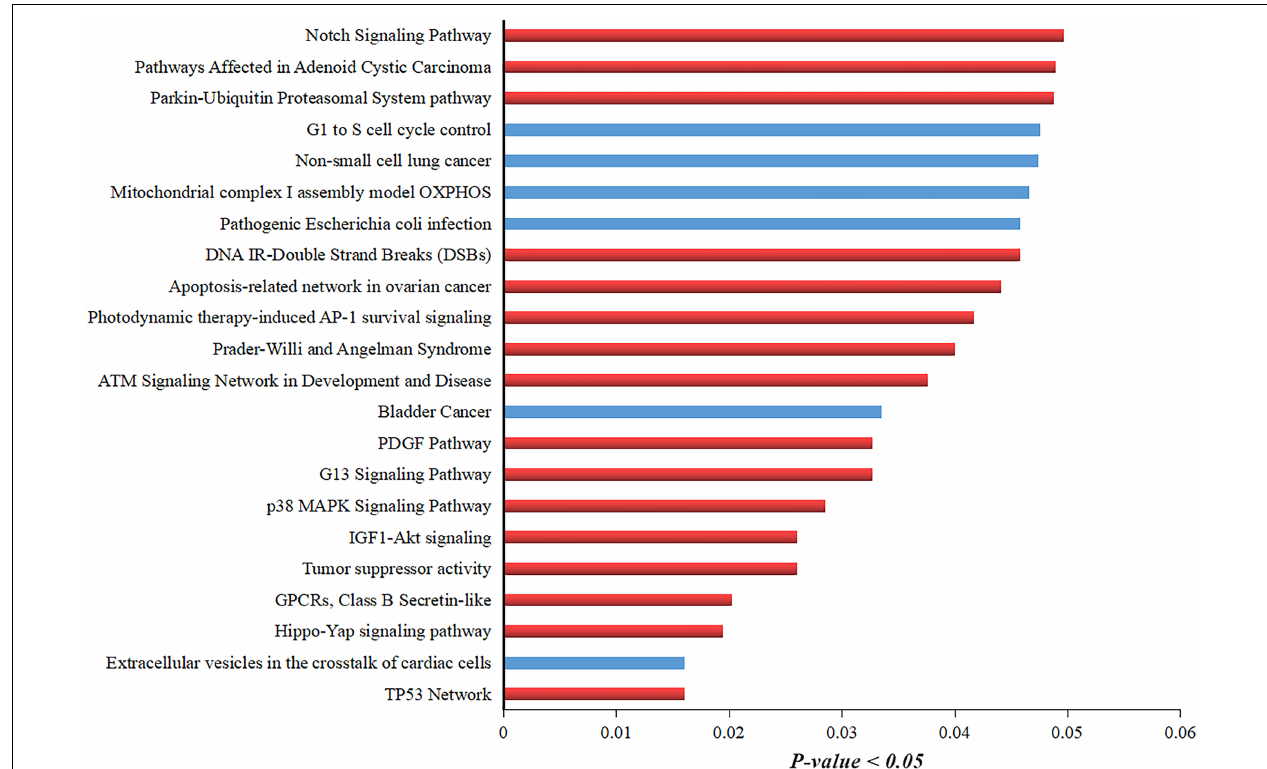
FIGURE 5 | GO analysis of translocation neighboring genes showing their involvement in different pathways controlling cervical cancer development. Pathway enrichment analysis of translocations neighboring genes. Red-colored bar indicates the pathways that are directly involved in HPV-mediated cervical cancer development. Blue-colored bar shows the pathways involved in other types of